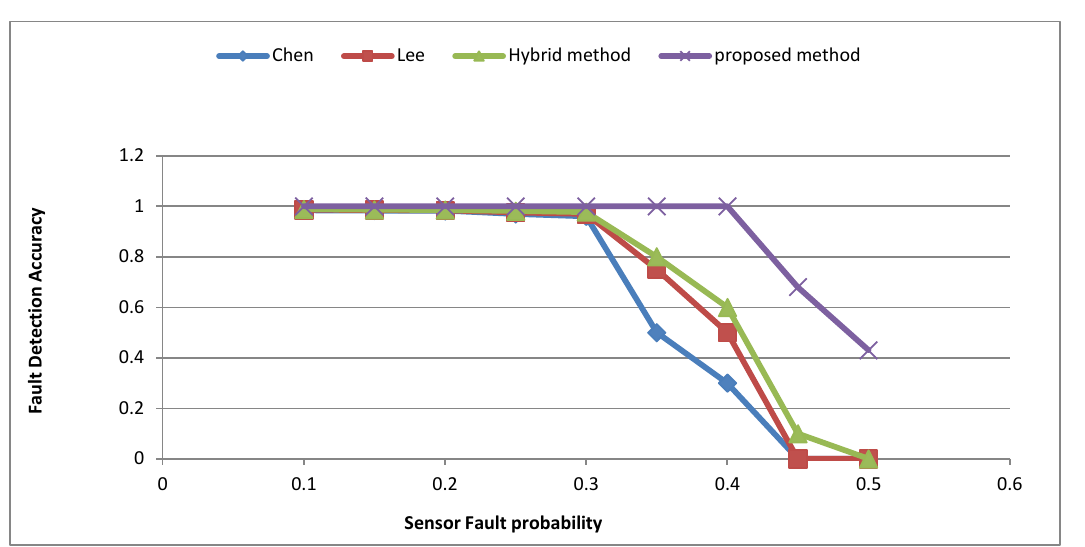
Figure 9. Fault alarm rate when N=150.